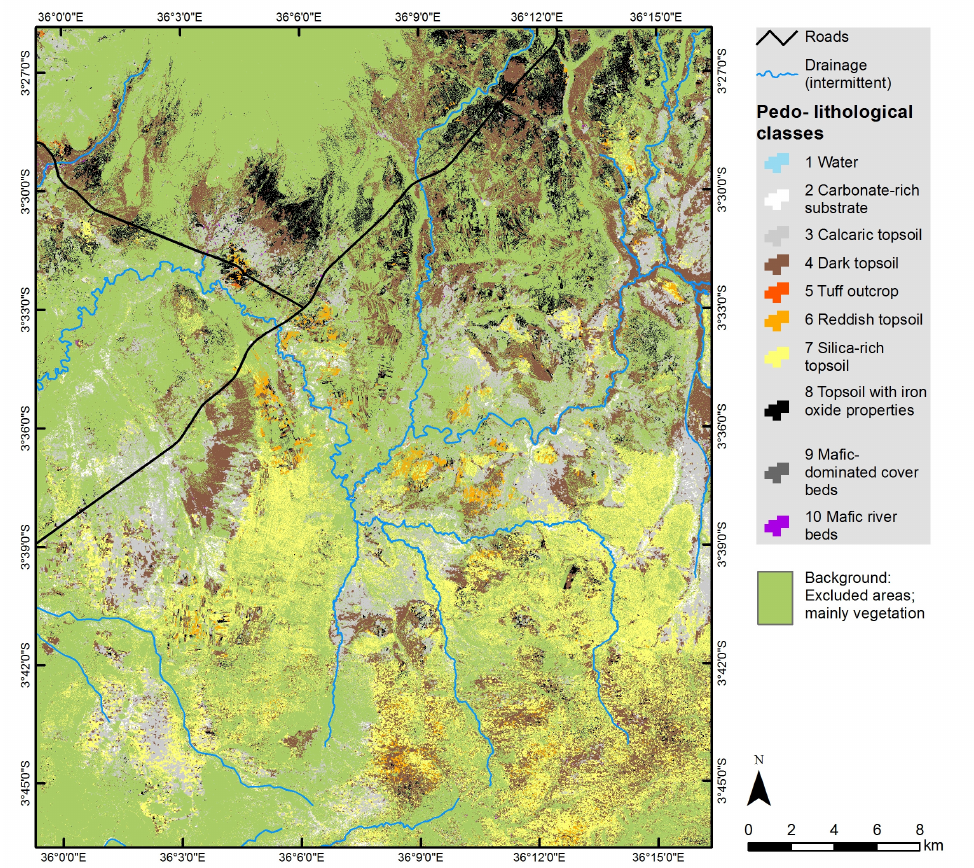
Figure 6. Final classification of topsoil distribution in the study